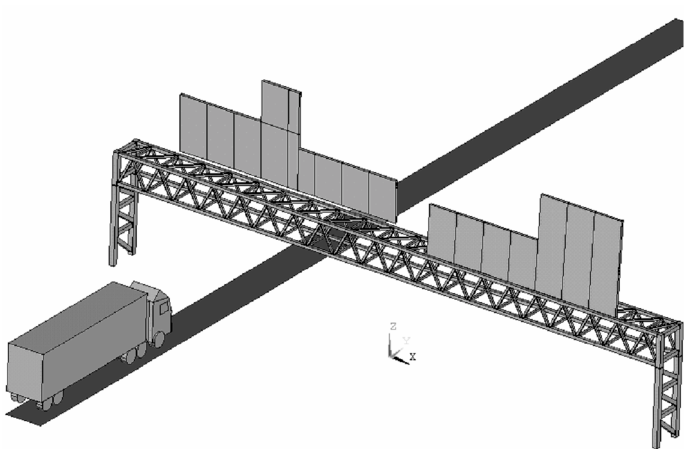
Figure 7. CAD model of HSV (moving zone), portal gantry (high resolution stationary zone), and zonal evolution track (lane in a carriageway).